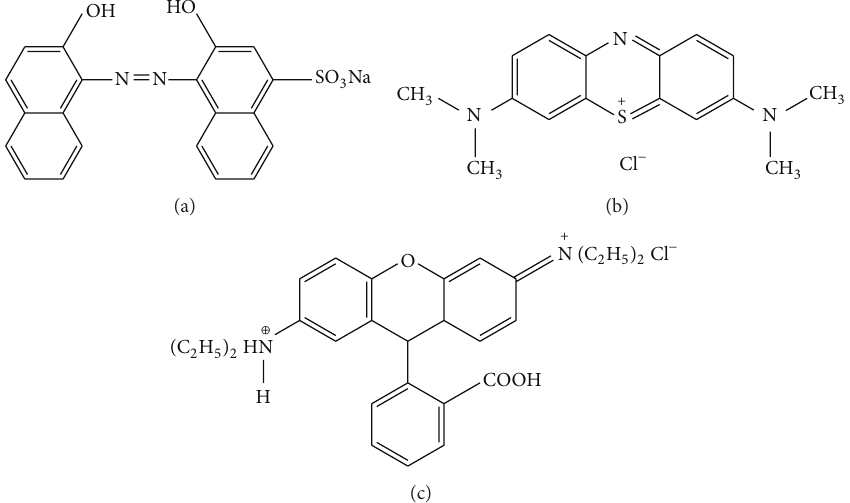
Figure 1: Structures of (a) Acid Blue 161, (b) Methylene Blue, and (c) Rhodamine B.